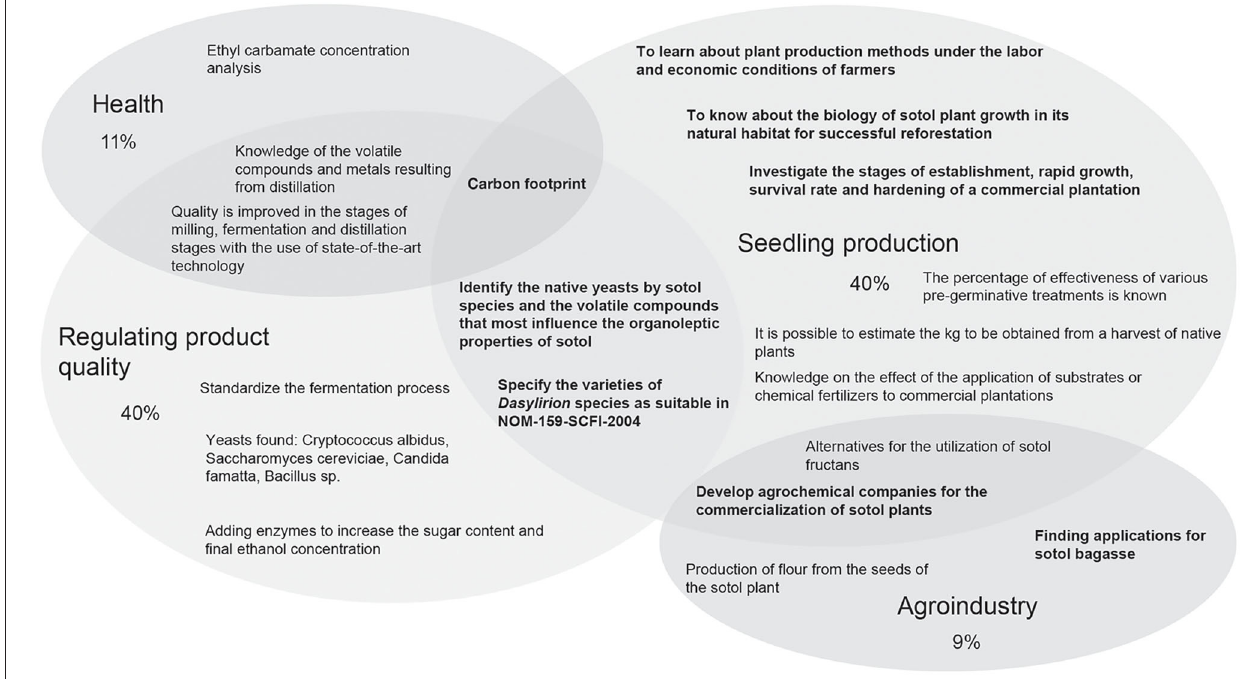
FIGURE 1 | Contributions from study disciplines and future